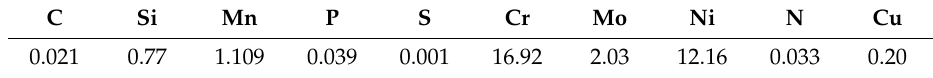
Figure 3. ( a ) Geometry of the U-groove; ( b ) all weld beads were divided into four layers: bottom layer, second layer, third layer, and cover layer. Table 1. Chemical compositions of the austenitic steel 316LN (wt %).